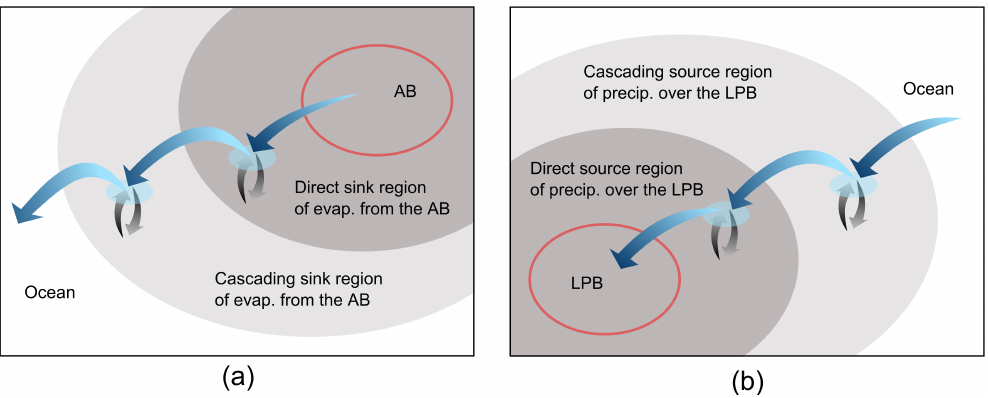
Fig. 4: Schematic representation of the sink and sources regions as quantified by the moisture recycling ratios. In addition to the direct source and sink regions identified using DMR ratios (dark gray), the cascading source and sink regions identified using CMR (light gray) are highlighted. Direct and cascading sink regions of evapotranspiration (evap.) from the Amazon basin (AB) (a) and direct and cascading source regions of precipitation (precip.) over the La Plata basin (LPB) (b) .